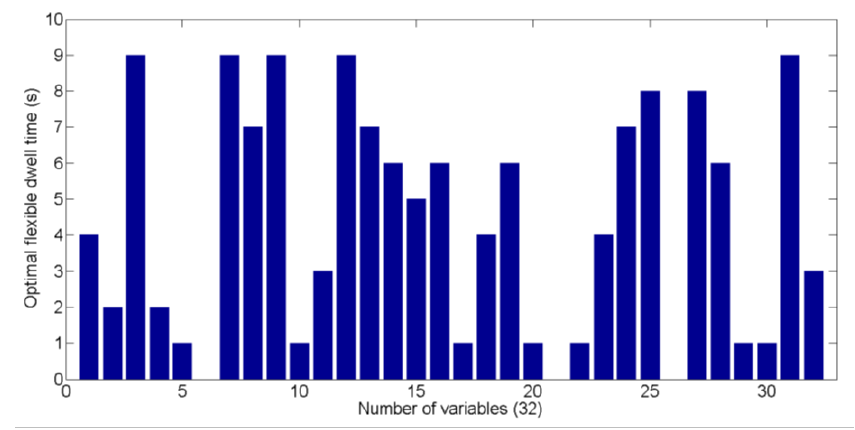
( b ) The best solution of the flexible dwell